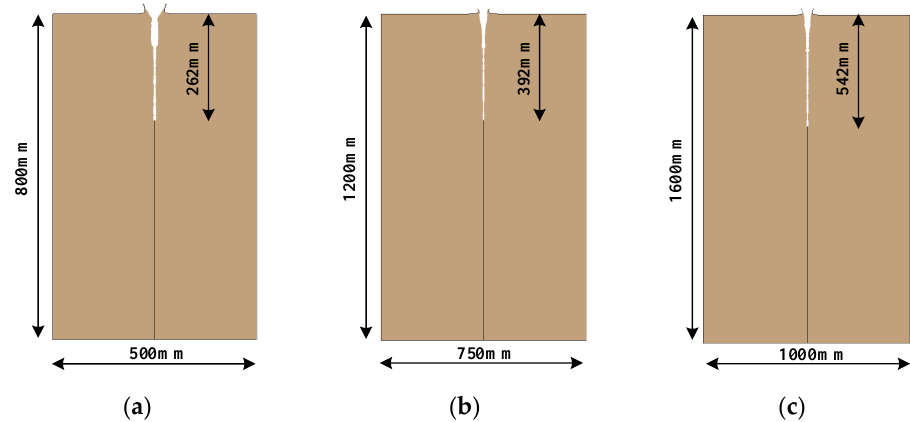
Figure 11. Charge diameters with liner angles of 60°: ( a ) 50 mm; ( b ) 75 mm; ( c ) 100 mm.